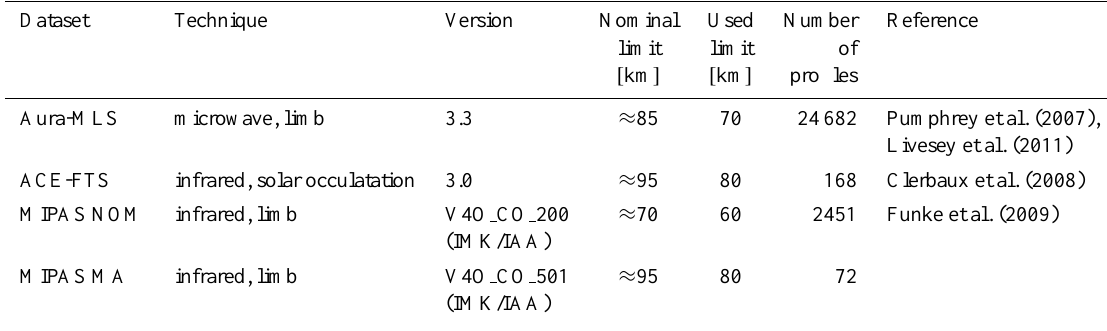
Table 4. Properties of the satellite instruments considered in this study. Dataset Technique